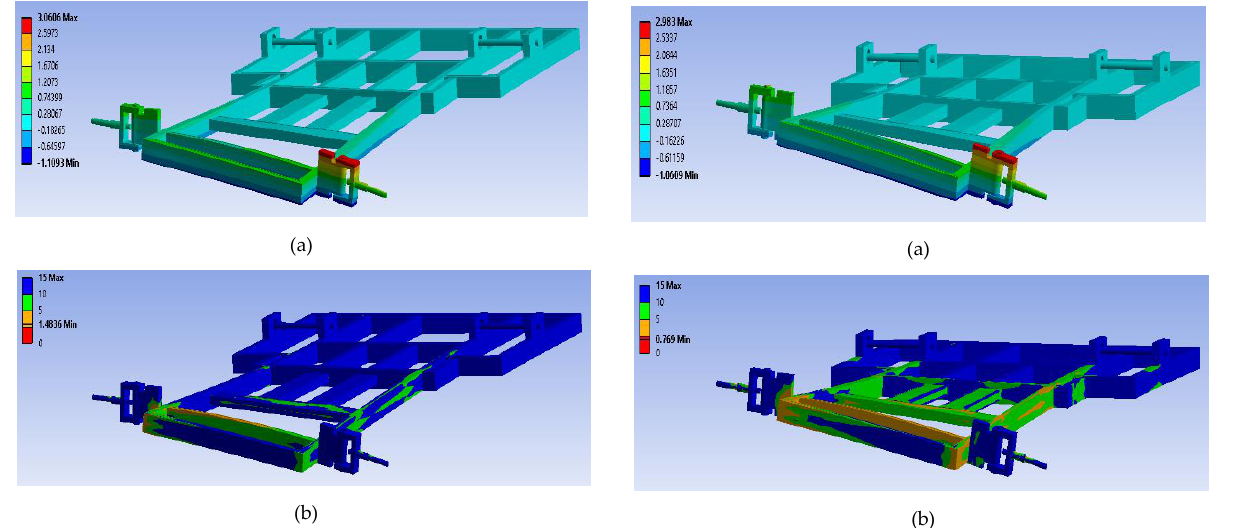
Figure 17: Deformation (a) and safety factor (b) of the sixth variation of chassis simulation